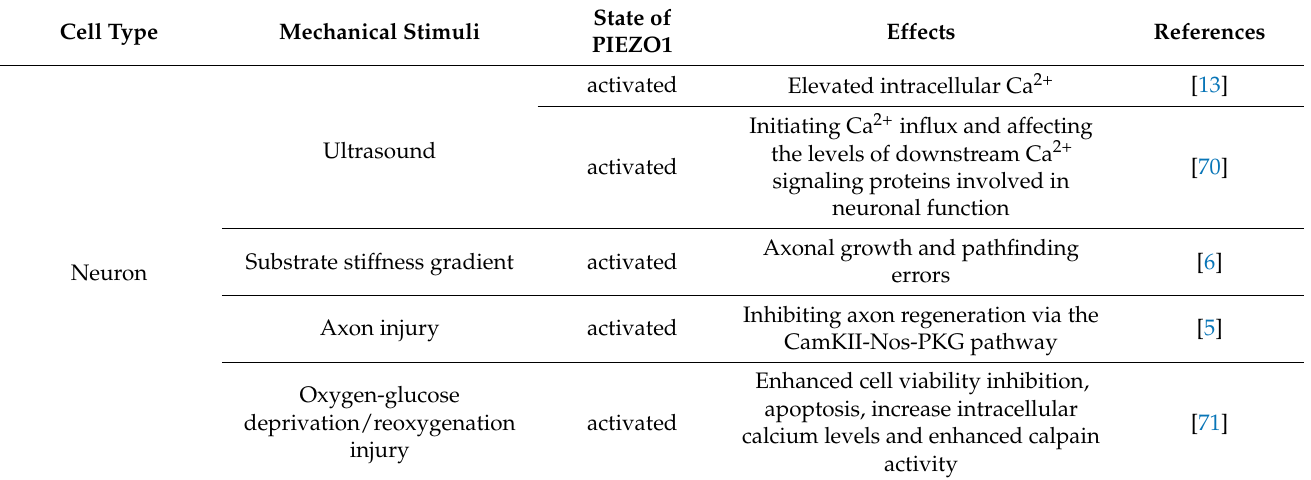
Table 1. Mechanotransduction of PIEZO1 in CNS